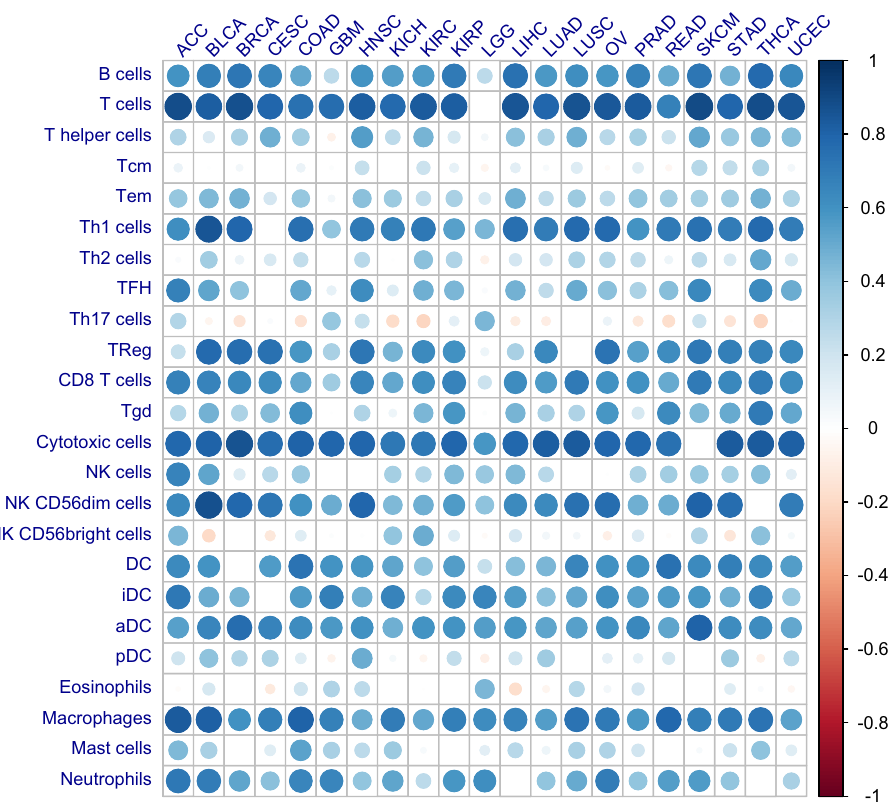
Figure 2. Correlation between expression of TLS signature and infiltration of immune cells. The Correlation between the enrichment score of TLS signature and 24 types of infiltrating immune cells was evaluated by Pearson Correlation analysis. Node color is determined by correlation, and node size indicates the significance of correlation. Only nodes with Correlation significance (false discovery rate < 0.05) were